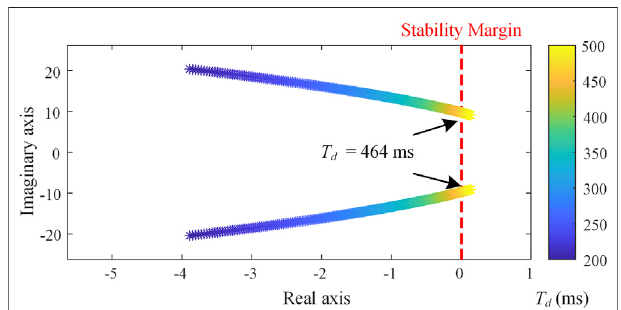
FIGURE 3 | Dominant eigenvalue of A .